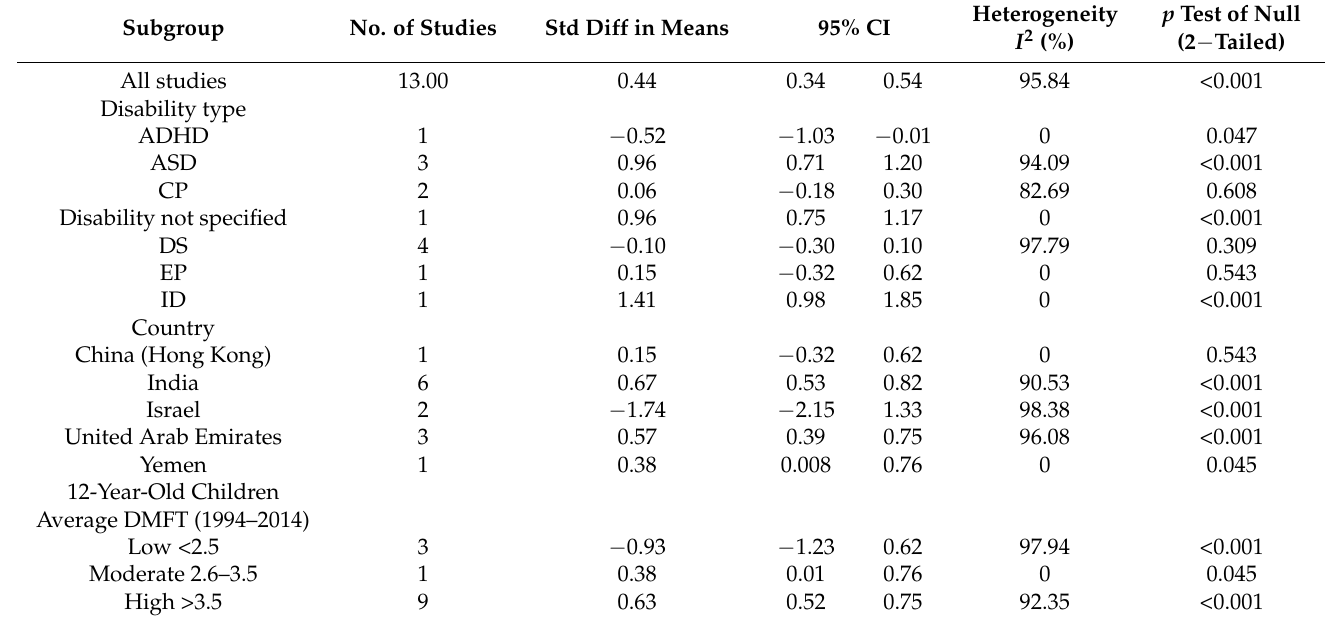
Table 3. Subgroup analysis of pooled DMFT index.